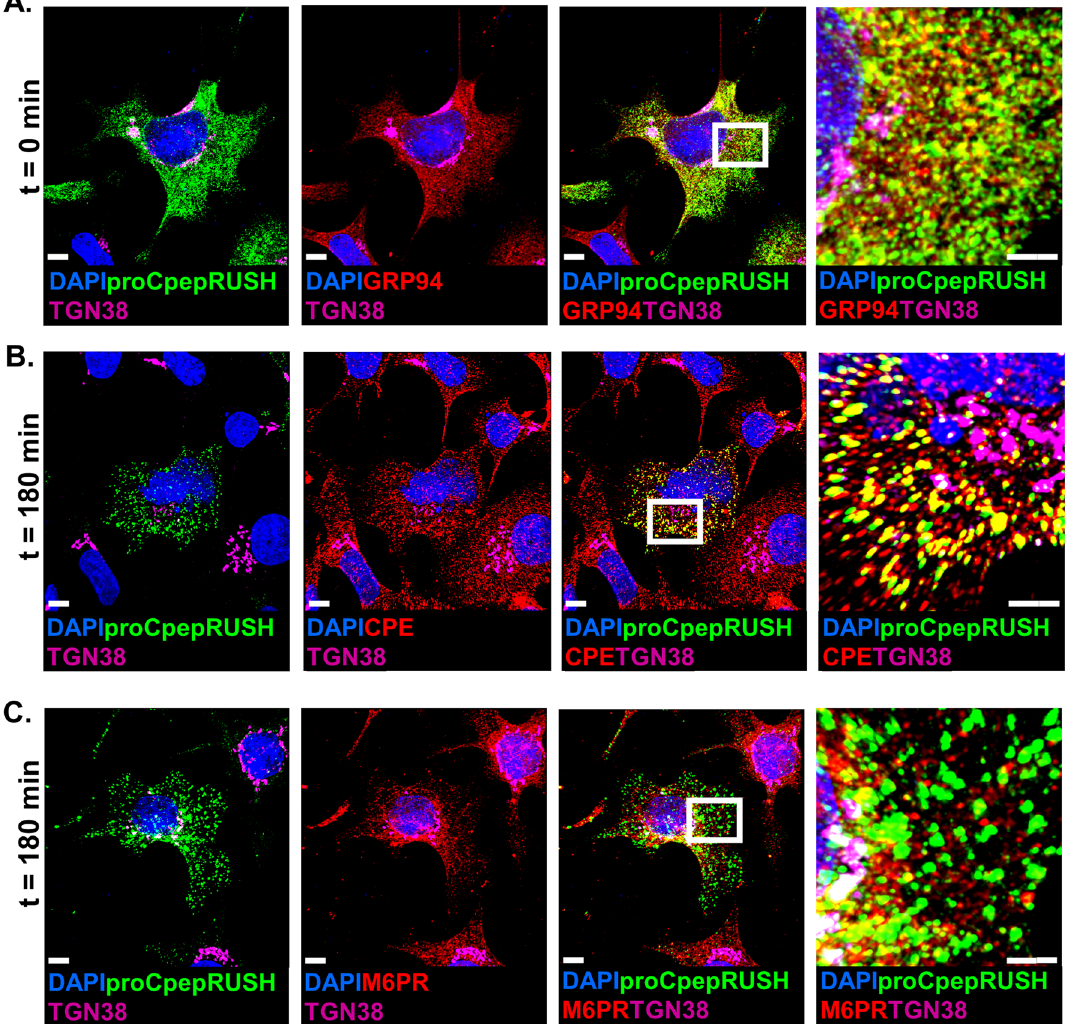
Figure 2. Co-localization marker analysis of proCpepRUSH trafficking. INS1 832/3 cells expressing AdRIP- proCpepRUSH were treated with biotin (200 μM) to initiate proCpepRUSH (green) trafficking for the indicated times prior to fixation. Cells were immunostained for GRP94 (red) ( A ), CPE (red) ( B ), or mannose-6-phosphate receptor (M6PR, red) ( C ). ( A - C ) TGN38 (magenta) and DAPI (blue) were used as counterstains. Boxed insets are shown with additional magnification. Scale bar = 5